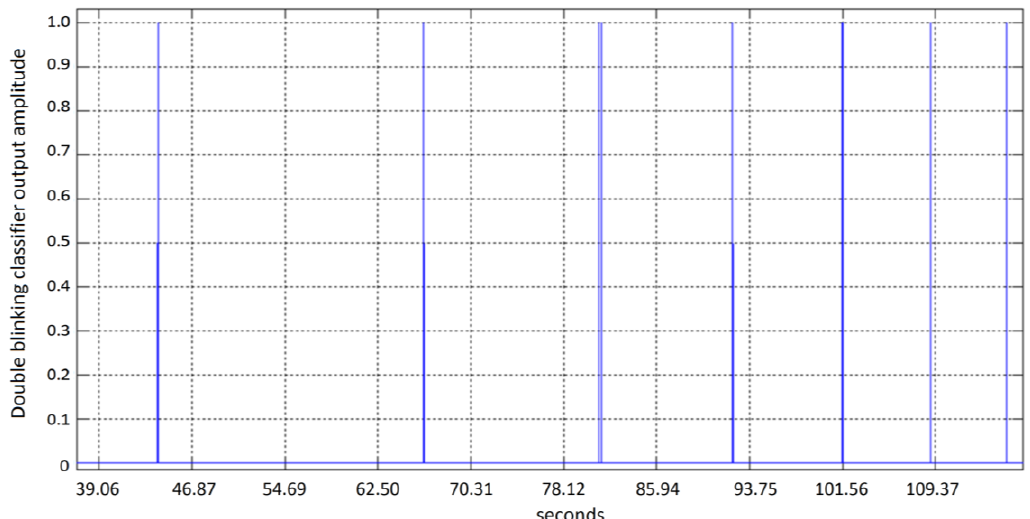
Figure 8. Double blinking detection with noise